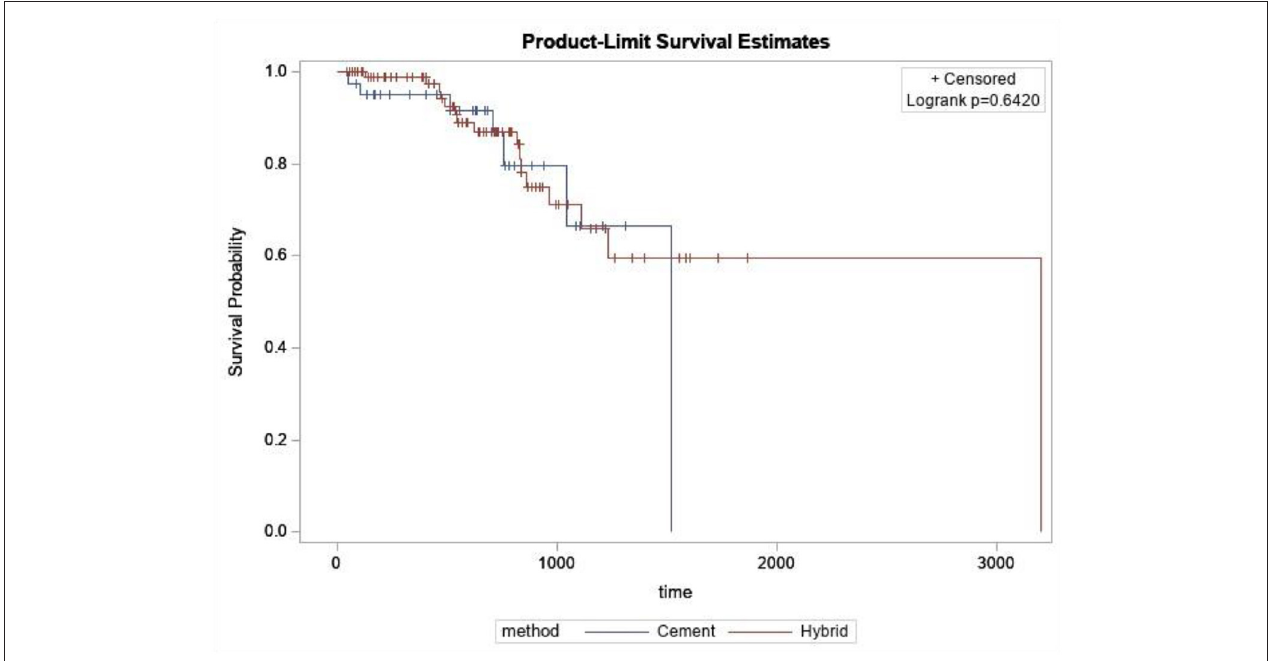
FIGURE 3 | Kaplan Meier survival curves after log-rank